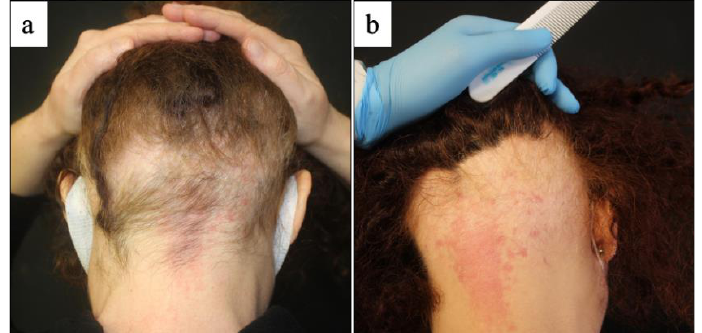
Figure 3. Clinical evaluation of alopecia areata at baseline and at 12 weeks of treatment: ( a ) a large area of alopecia (ophiasis pattern) on the occipital scalp in a 39-year-old female with history of alopecia, showing worsening ( b ) of hair loss after treatment with systemic cyclosporin and topical 0.05% clobetasol solution.